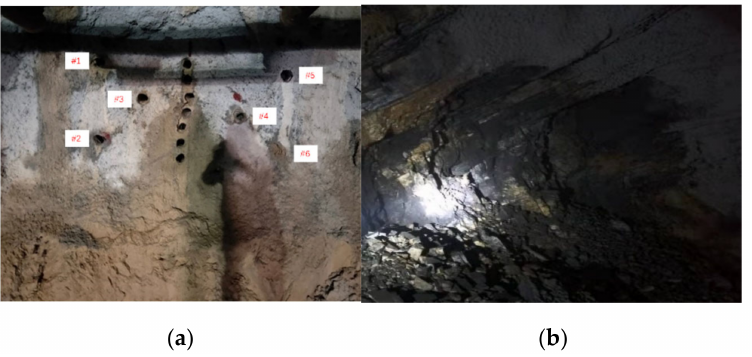
Figure 10. The comparison before and after cutting rock mass cracking in test 2. ( a ) Tunnel face before cutting rock mass cracking; ( b ) Tunnel face atter cutting rock mass